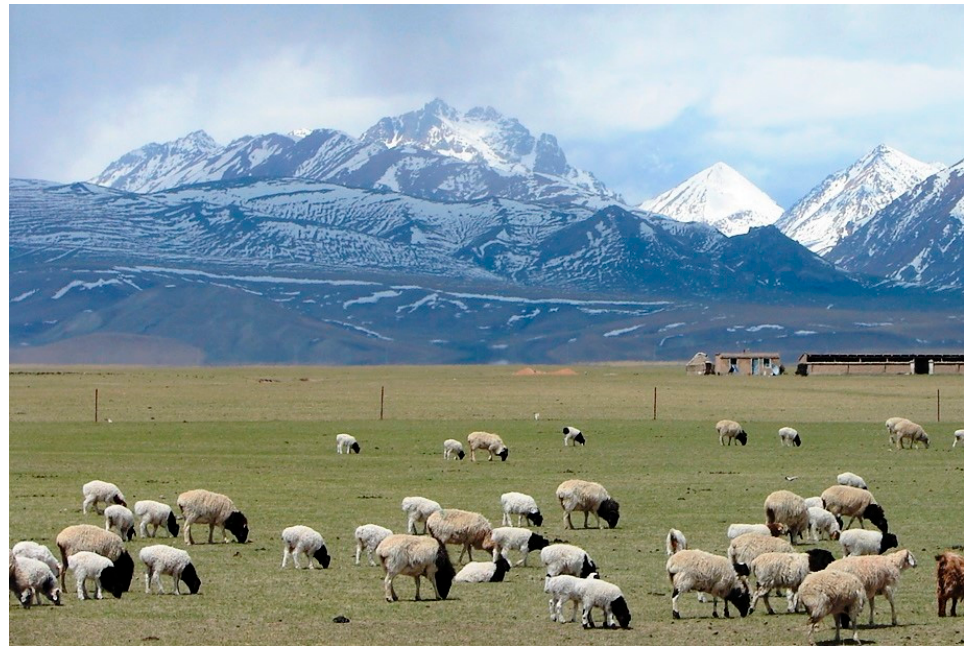
Figure 4. Alpine grasslands on the Qinghai–Tibet Plateau, especially alpine meadows, are prime grazing lands. Government policy is to regulate grazing pressure through imposition of grazing bans and restrictions on herder mobility (transhumance) (photo: V.R.